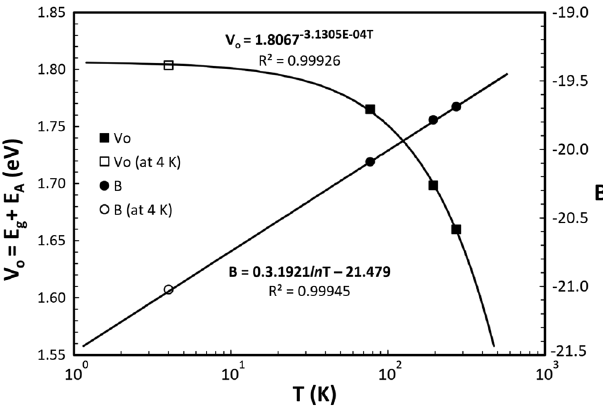
FIG. 4. Exponential fit of the photoemission threshold V (square) and parameter B (circle), each obtained from the QE spectral fit for each temperature indicated in Fig. 3. The open markers indicate extrapolation of V